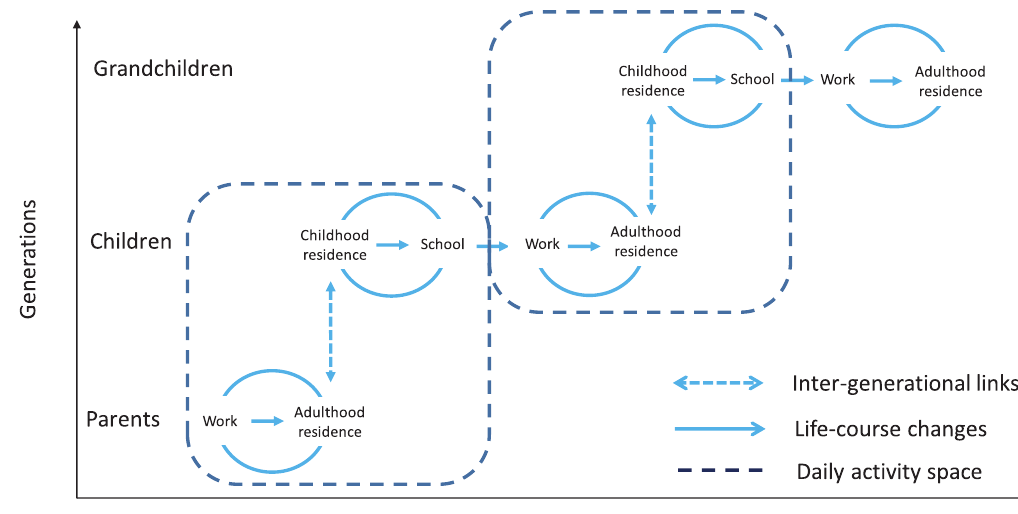
Figure 2. The conceptual framework of vicious circles of